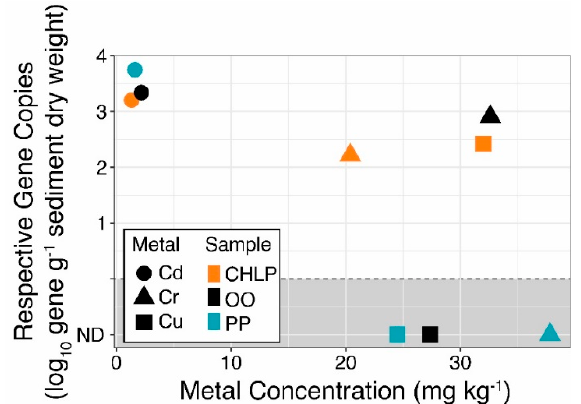
Figure 6. The concentrations of cadmium (Cd), chromium (Cr), and copper (Cu) in the three sediments compared to respective gene copies quantified by qPCR. Replicates were used to calculate the average metal concentration ( n = 2) and gene abundances ( n = 3). Note that mercury (Hg) was not quantified in this analysis. The dashed line represent 10 0 and undetected (ND) genes are shown below this line in the gray, shaded